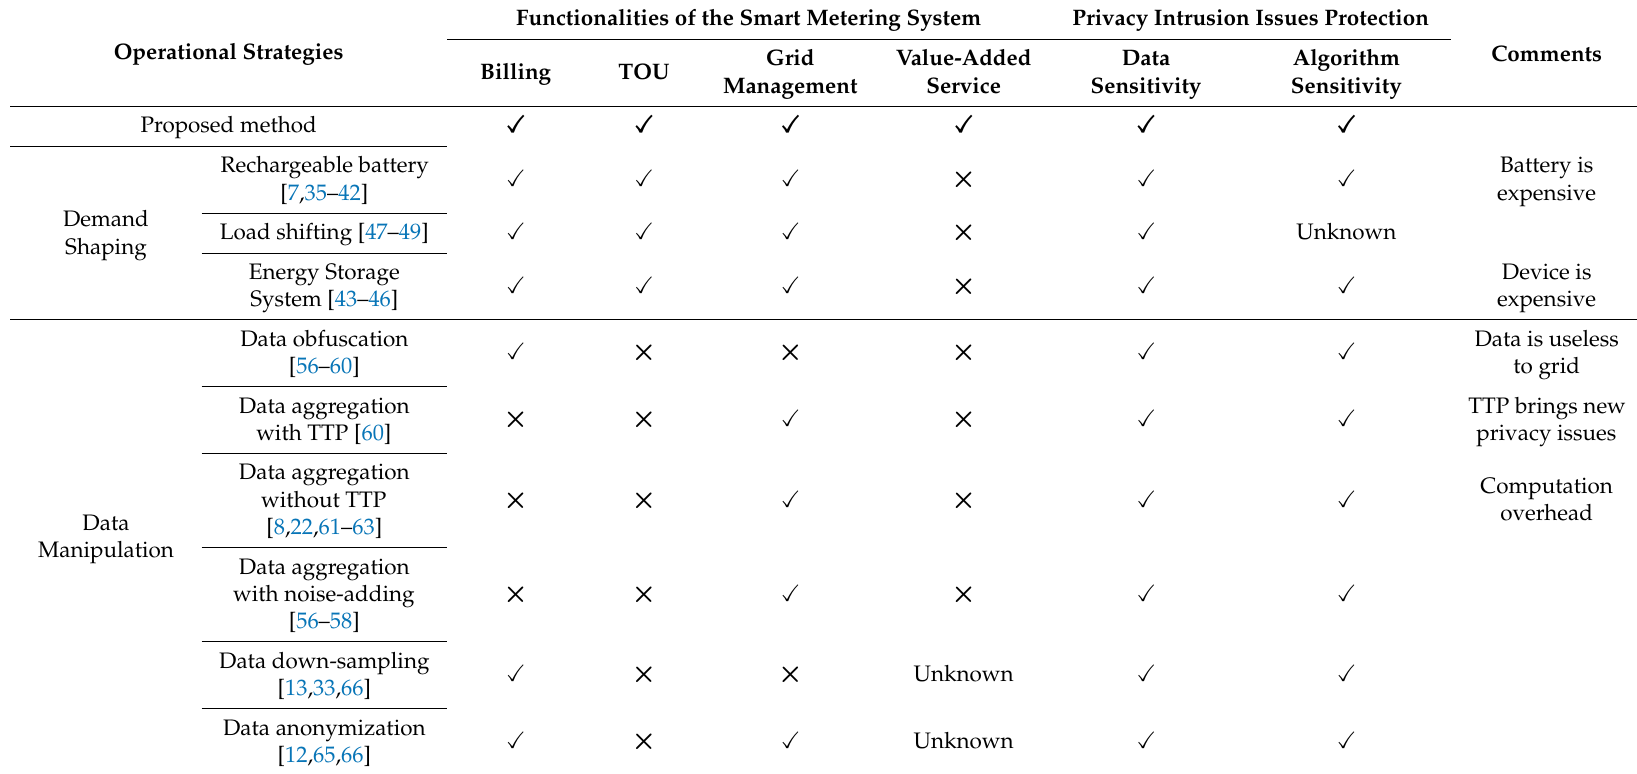
Table 4. Comparison of the performance between proposed method and related operational